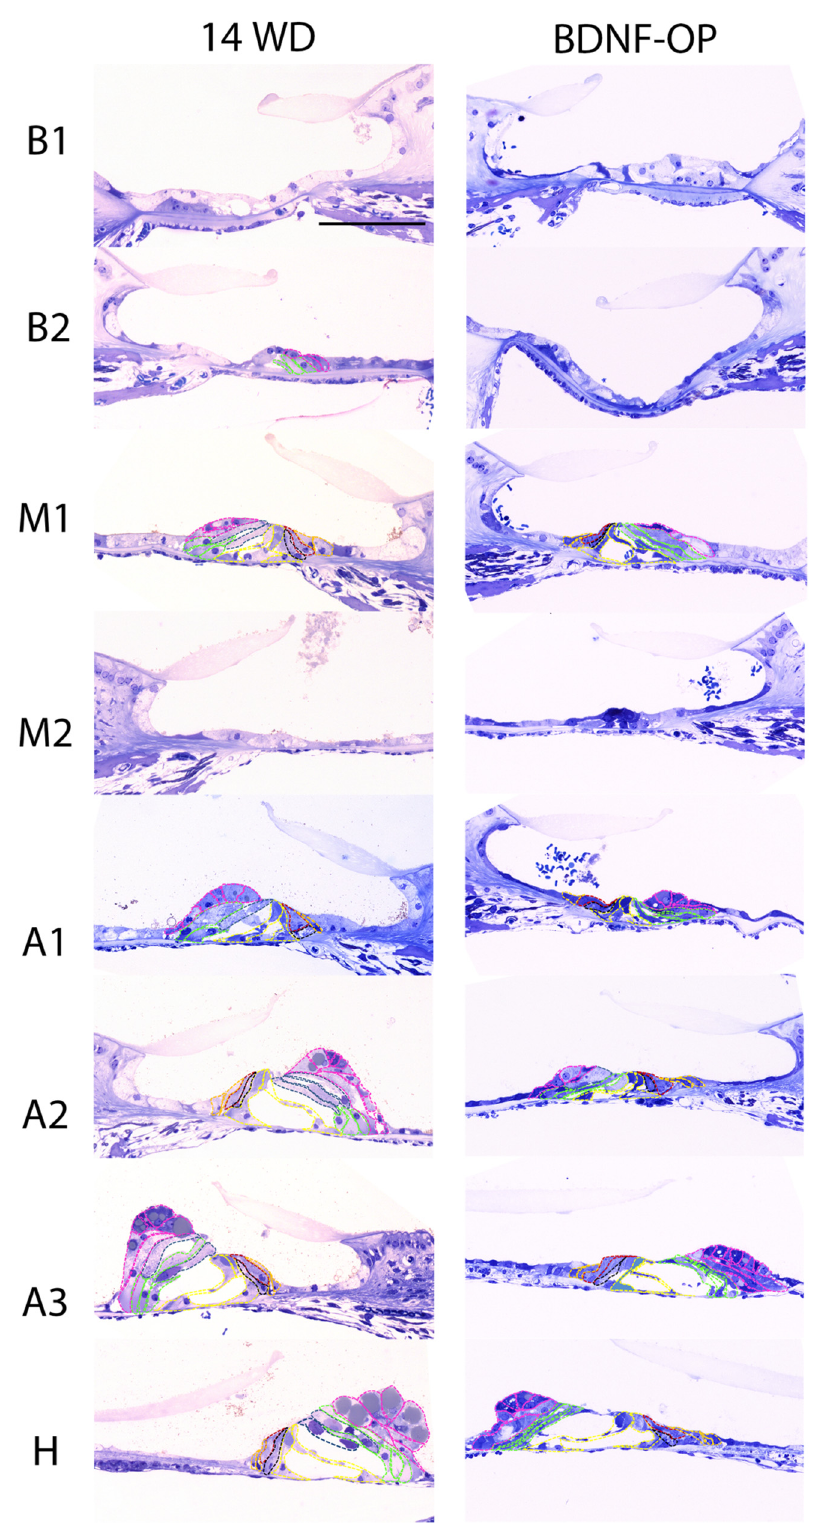
Figure 7. Representative images of the organ of Corti from BDNF-treated animals through mini-osmotic pump (BDNF-OP). Microscope pictures are representative of the organ of Corti of untreated (fourteen weeks deaf: 14WD) ( left ) and BDNF-OP cochleas ( right ) of all cochlear locations: B1, B2, M1, M2, A1, A2, A3, H. Hair cells and supporting cells were identified by using a color coding: outer hair cells (blue), inner hair cells (red), border (orange), phalangeal (black), pillar (yellow), Deiters’ (green), and Hensen’s (pink). Scale bar: 50 µm.